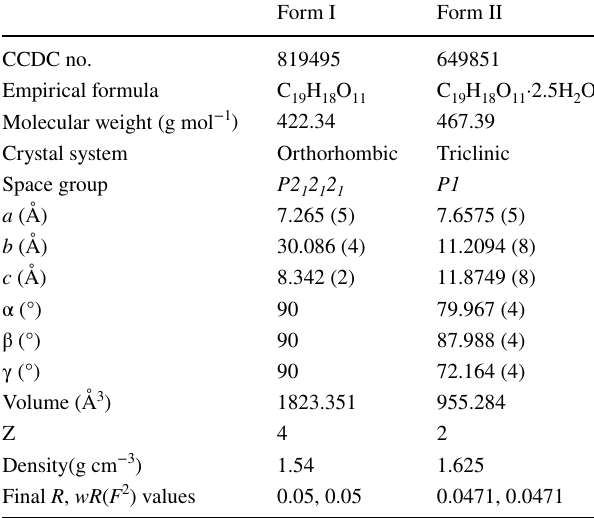
Table 2 Crystallographic data for two polymorphs of